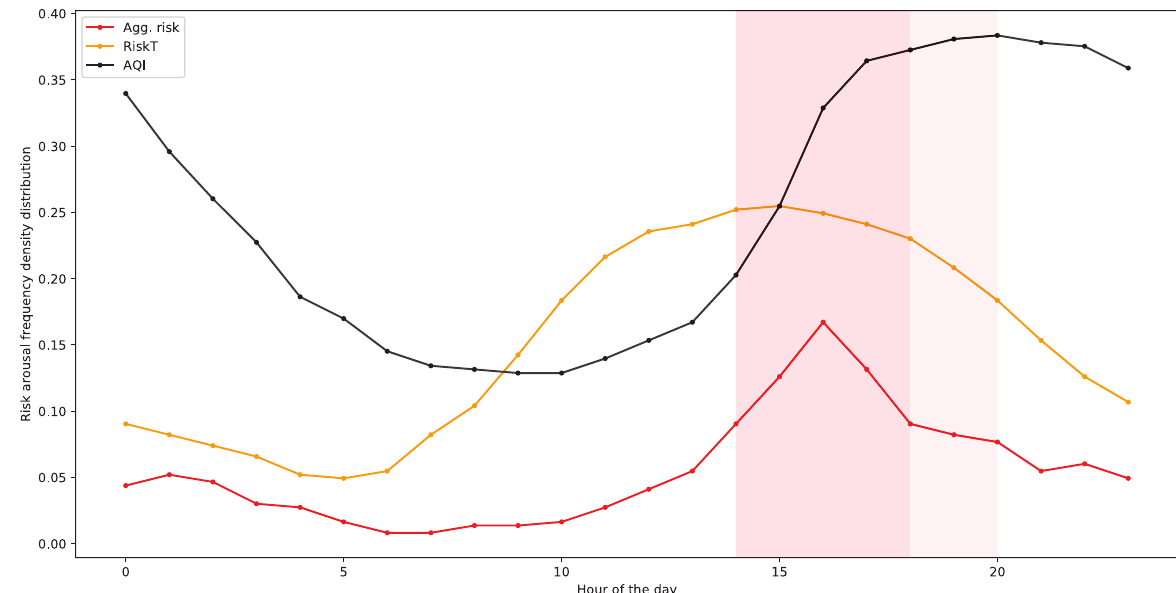
Figure 7. Conjoint risk (Agg. risk) daily profile of the hourly frequency distribution on a yearly basis for 2019’s data extracted from Milano v.